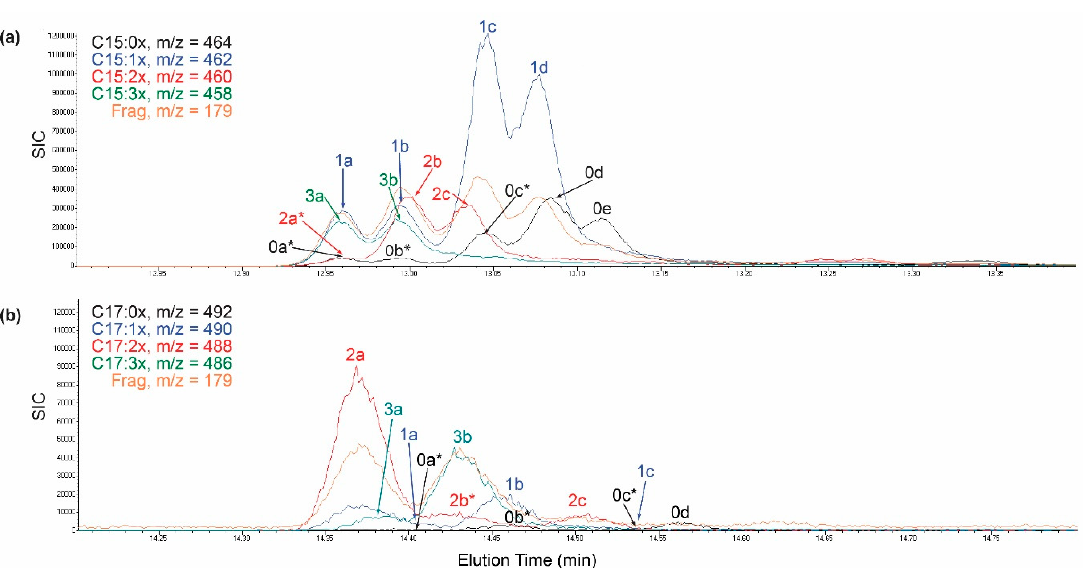
Figure 1. GC-MS analysis of alkylphenol levels in poison ivy accessions. ( a ) combined total C15- and C17-urushiol levels. ( b ) blue, total C15-cardanol; red, total C:15-urushiol; and green, total C17- urushiol levels. ( c ) ratio of total C15:C17 urushiol levels.